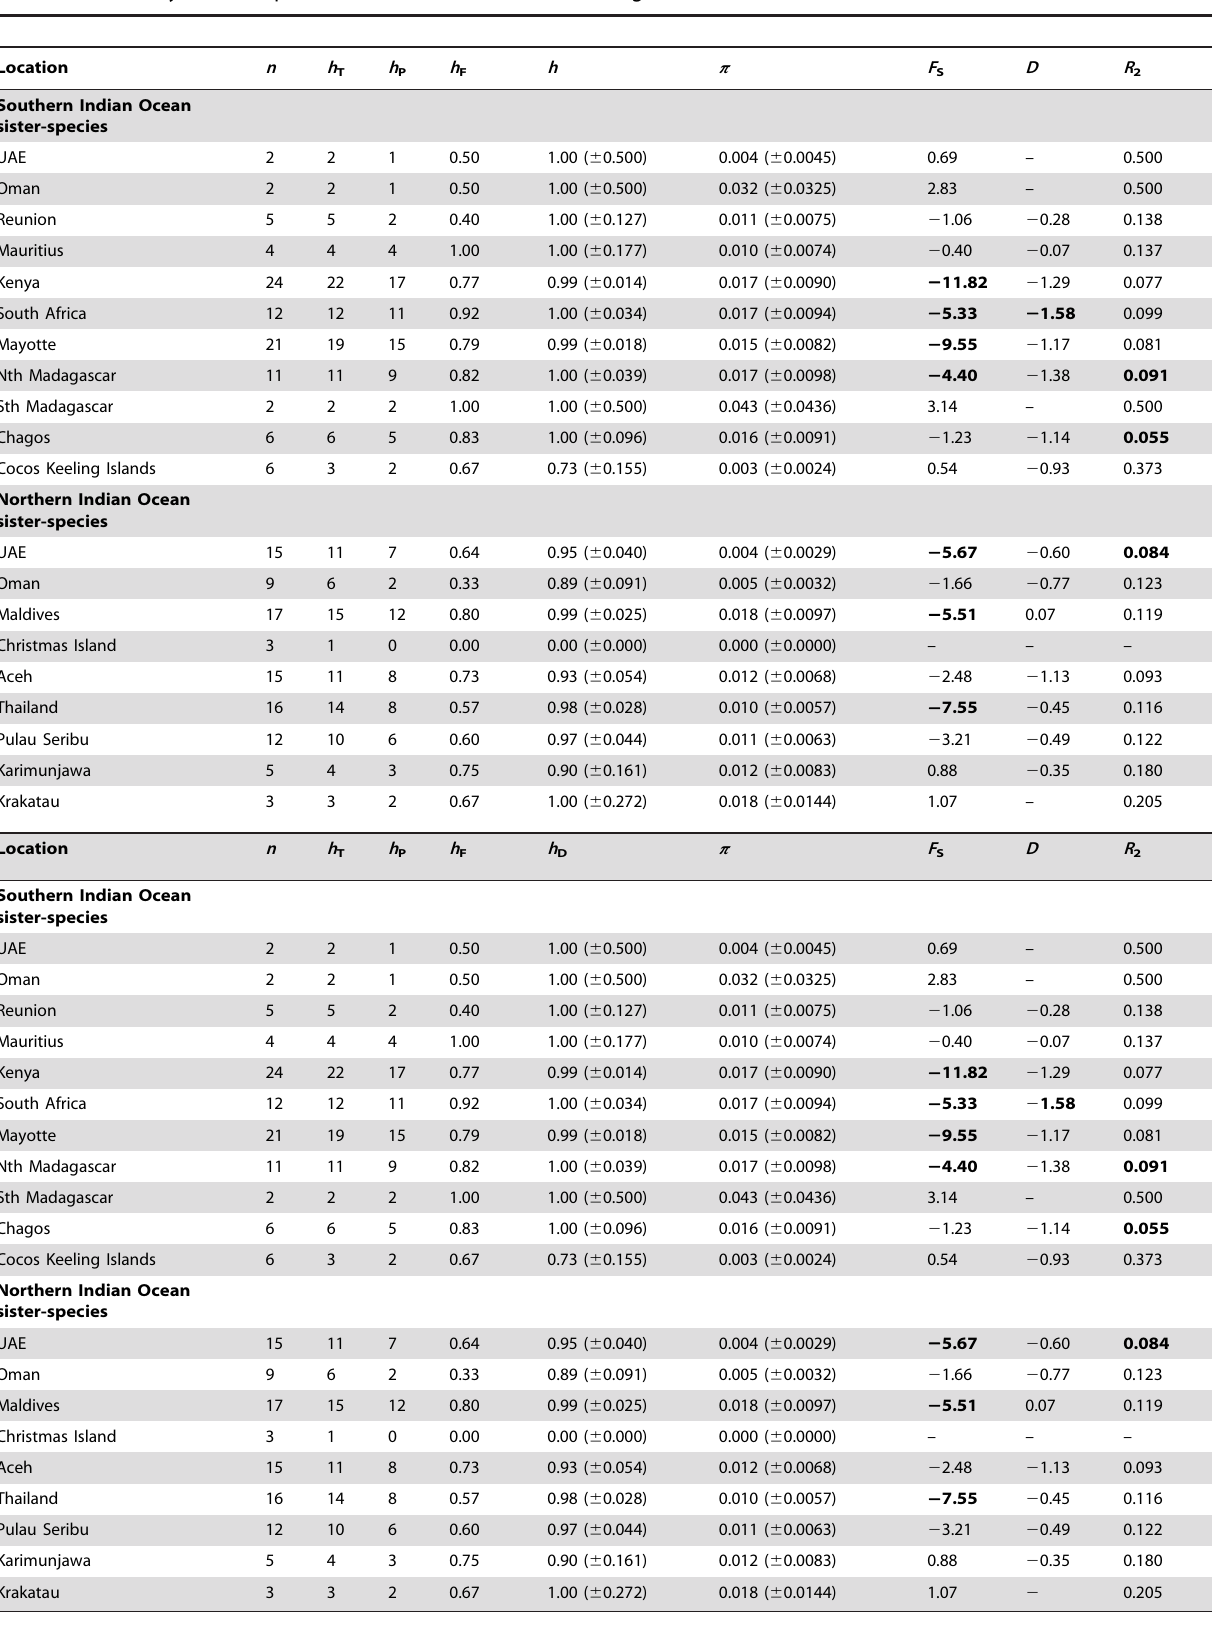
Table 3. Summary statistics per location based on the Control Region